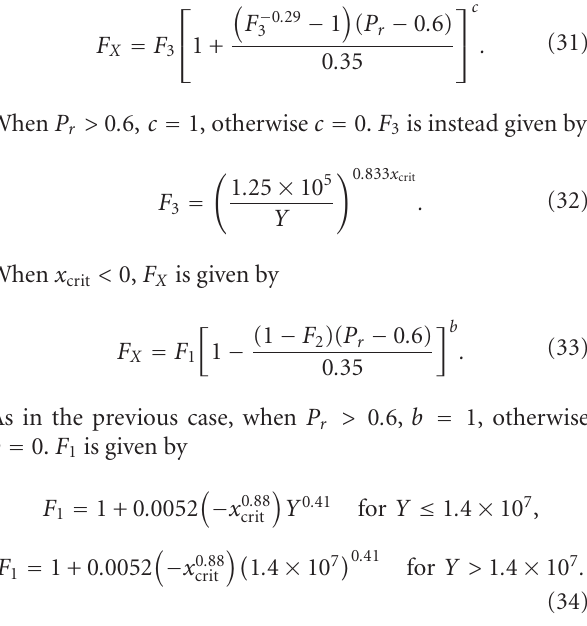
Bo 0 is defined as the boiling number at x crit = 0, given